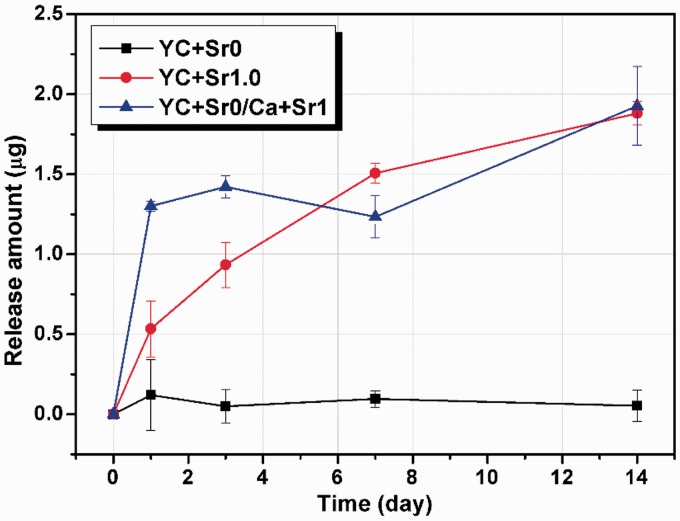
Sr2+ release amount curves of YC + Sr0, YC + Sr1.0 and YC + Sr0/Ca + Sr1 in L-DMEM